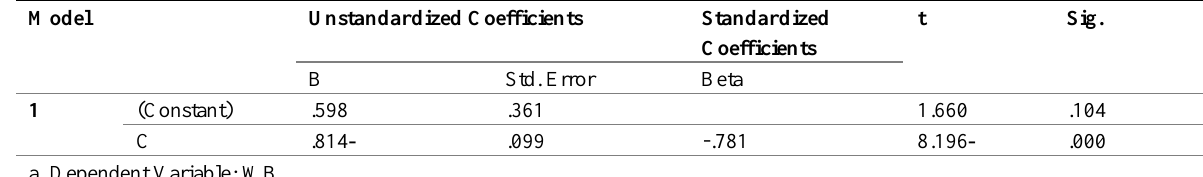
Table 14: Results of Linear Regression between Compassion and Workplace